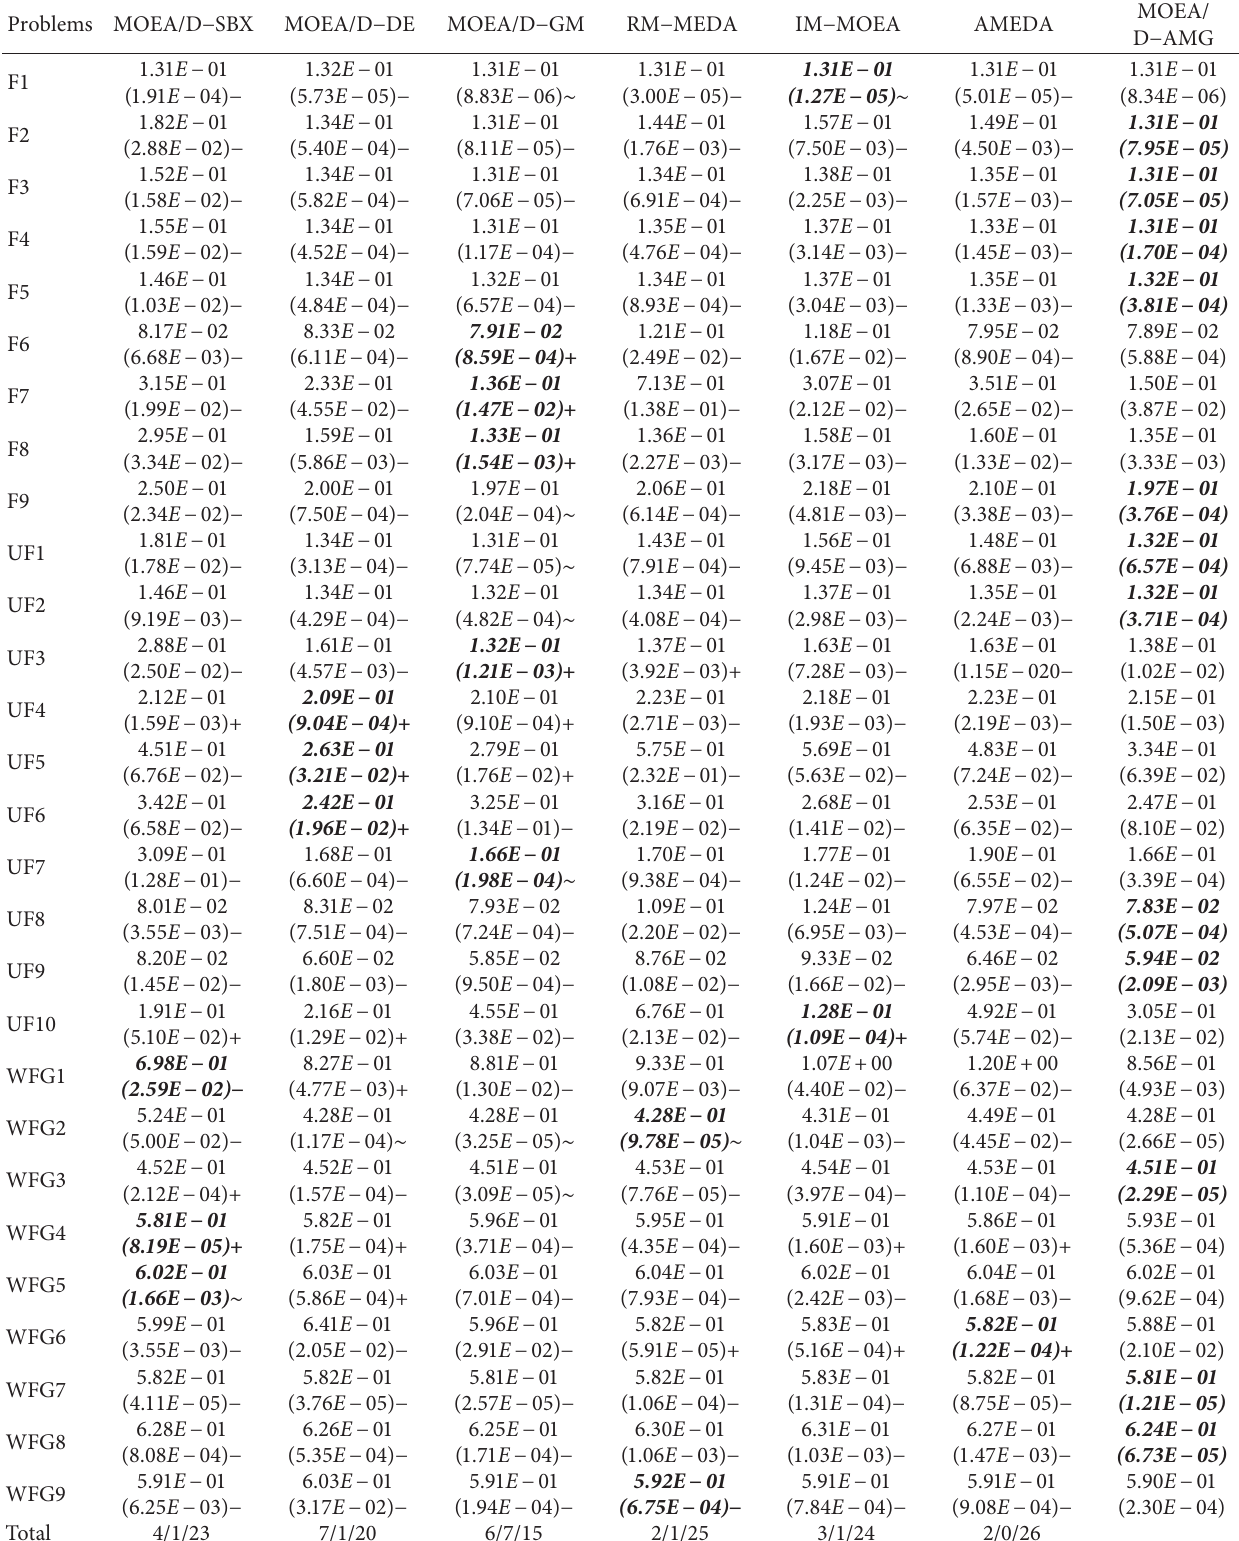
Table 3: Performance comparison of MOEA/D-SBX, MOEA/D-DE, MOEA/D-GM, RM-MEDA, IM-MOEA, AMEDA, and MOEA/D- AMG in terms of the average R2 values and standard deviation on F, UF, and WFG